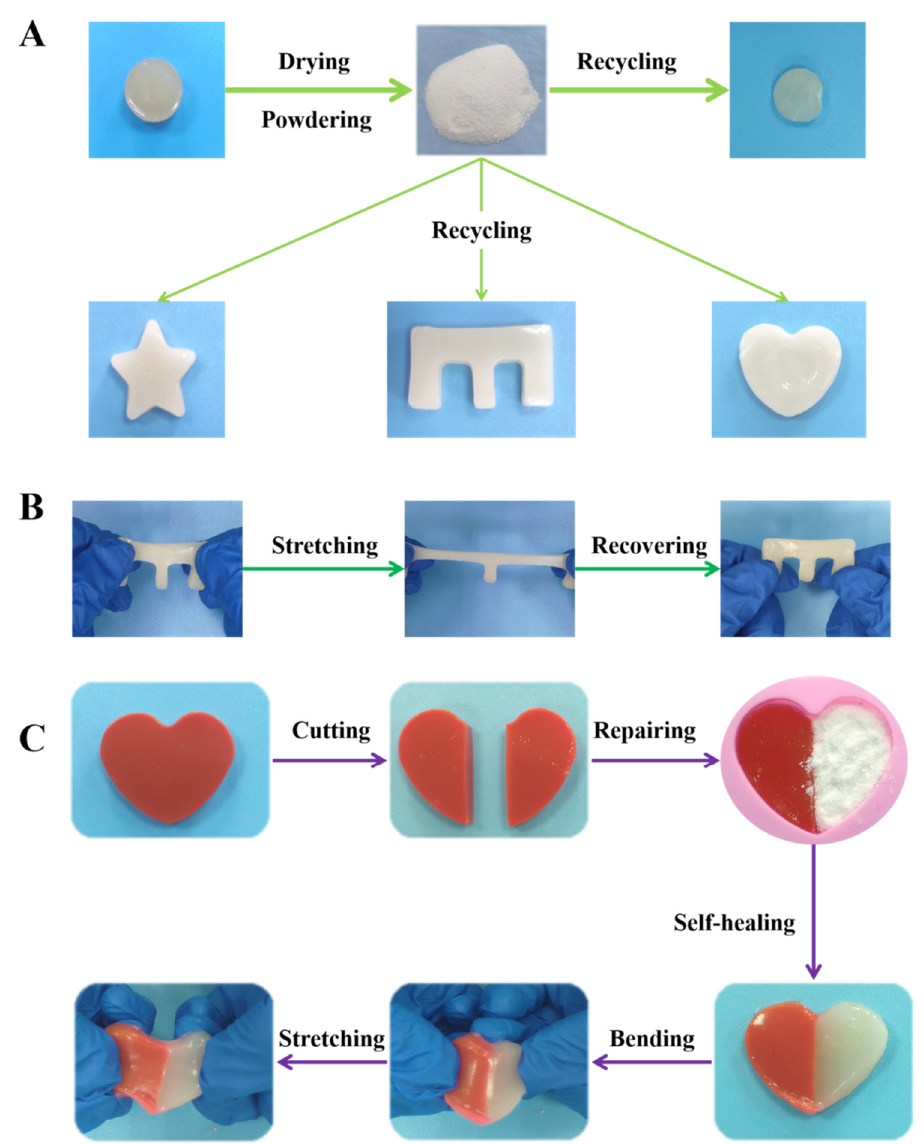
Figure 4. ( A ) Photographs of powder self-healing abilities of CMA-3 hydrogel. ( B ) Photographs of CMA-3 hydrogel exhibiting excellent stretching flexibility. ( C ) Photographs of CMA-3 hydrogel repairing partially missing hydrogel.